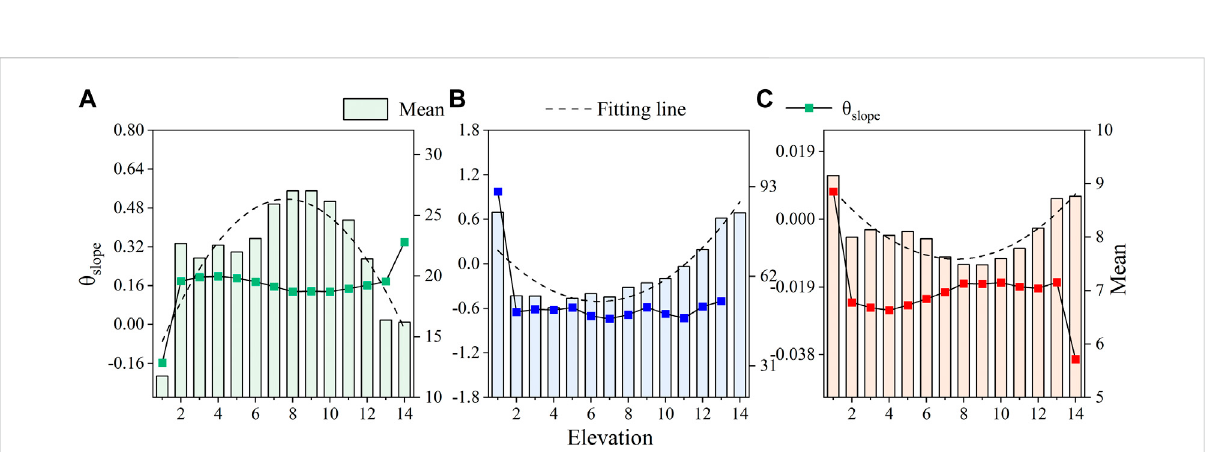
FIGURE 9 Effect of elevation on soil water – salt: (A) effect of elevation on SWC, (B) effect of elevation on EC, and (C) effect of elevation on pH. Note: 1 – 14represent2000 – 2,100,2,100 – 2,200,2,200 – 2,300,4,500 – 4,600,4,600 – 4,700,and > 4,700,respectively;constrainedconditions:theslopeof 4 ° – 8 ° and aspect of